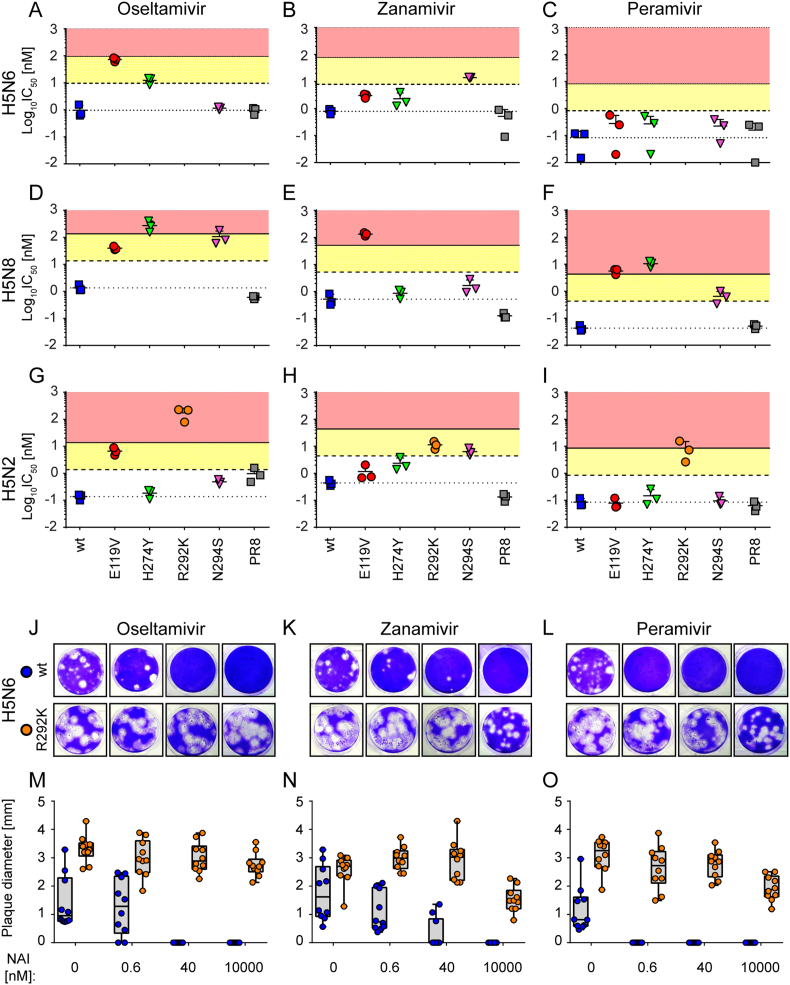
Neuraminidase inhibitor (NAI) susceptibility profile of H5N6, H5N8 and H5N2 influenza viruses. (A–I) MUNANA assay. The IC50 values for three H5Nx viruses: H5N6 (A–C), H5N8 (D–F) and H5N2 (G–I) were determined by fluorescent NA inhibition assay. Each panel of viruses (R292K only for H5N2) alongside with the PR8 strain were tested for their susceptibility to OSE (left column), ZAN (middle column) and PER (right column). Short horizontal line with error bar indicates the mean of log10IC50 [nM] ± SD of three independent experiments; each data point represents a single experiment. The area between the dotted and dashed lines on each graph represents the normal inhibition (NI; <10-fold increase in IC50 over corresponding wt), the yellow-shaded area - reduced inhibition (RI; 10 - 100-fold increase in IC50) and the red-shaded area – highly reduced inhibition (HRI; 100<-fold increase in IC50). (J–O) Susceptibility profile of H5N6 carrying R292K NA substitution to NAIs as determined by plaque reduction assay. MDCK cells were infected with H5N6 viruses bearing either wt (blue) or R292K (orange) NA variants. The cells were cultured with increasing NAI concentrations (0–10 μM): OSE (left column), ZAN (middle column) or PER (right column). The plaques were developed after 72 h of incubation (J–L) and the plaque sizes were measured for at least 10 plaques per condition (M–O). Box and whiskers graphs in M-O represent the median plaque diameter with minimum and maximum values [mm]; each data point represents a single plaque.